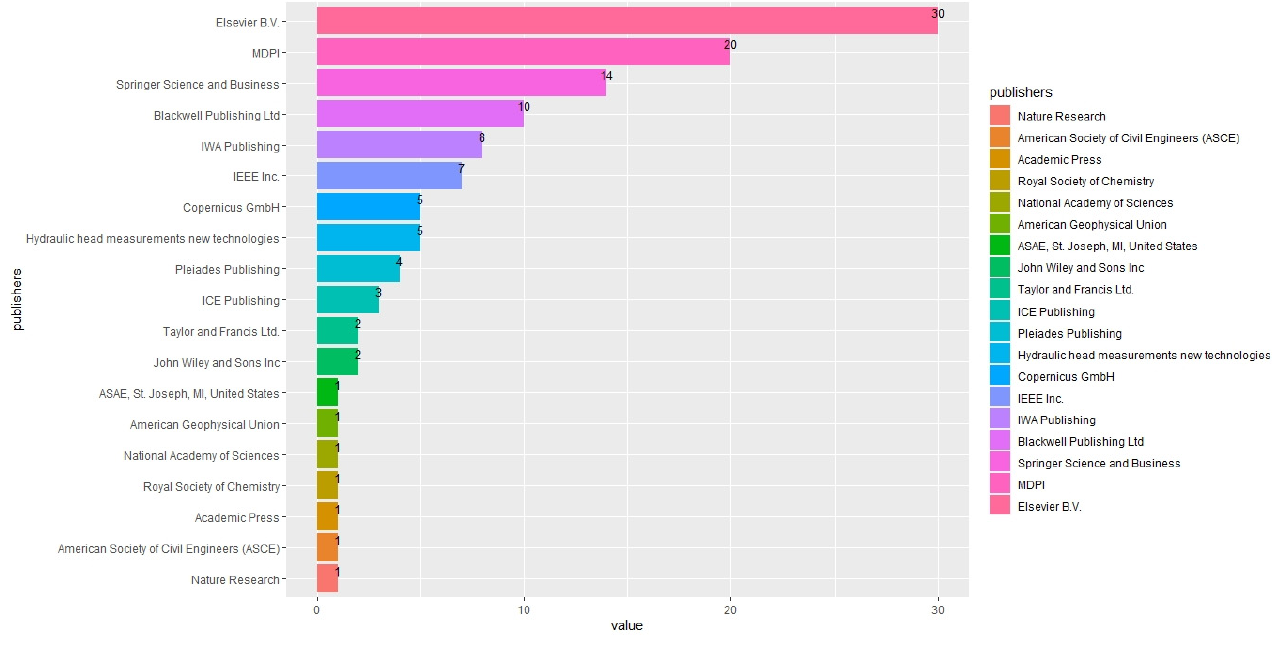
Figure 6. Distribution by country, based on origin of corresponding author.